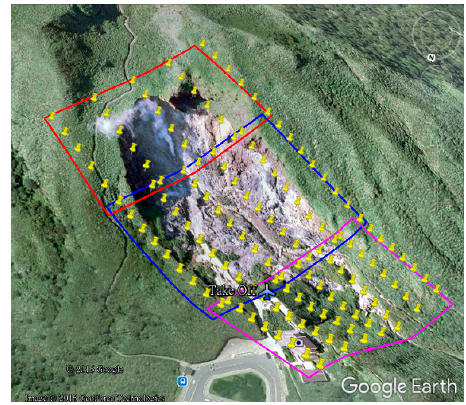
Figure 6. Study area at Hsiaoyukeng in the Tatun volcano group.